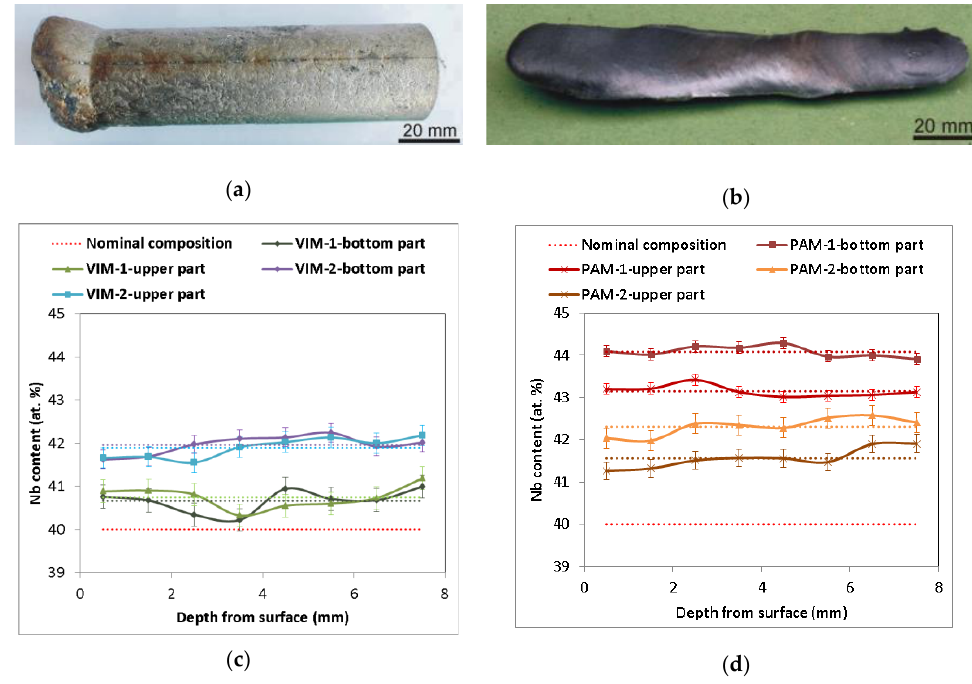
Figure 1. ( a ) Sample Nb – Al-VIM-1 after induction melting; ( b ) sample Nb – Al-PAM-1 after plasma arc